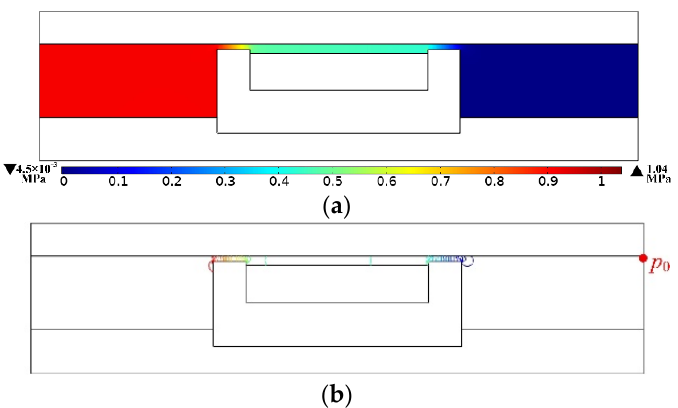
Figure 12. Pressure distribution of MR damper. ( a ) Cloud chart of pressure distribution. ( b ) Contour map of pressure distribution.